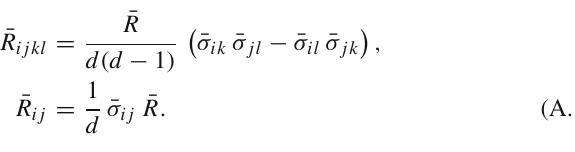
(V), spatial, symmetric tensors (T), transverse spatial vectors (TV), and symmetric, transverse-traceless spatial tensors (TTT),